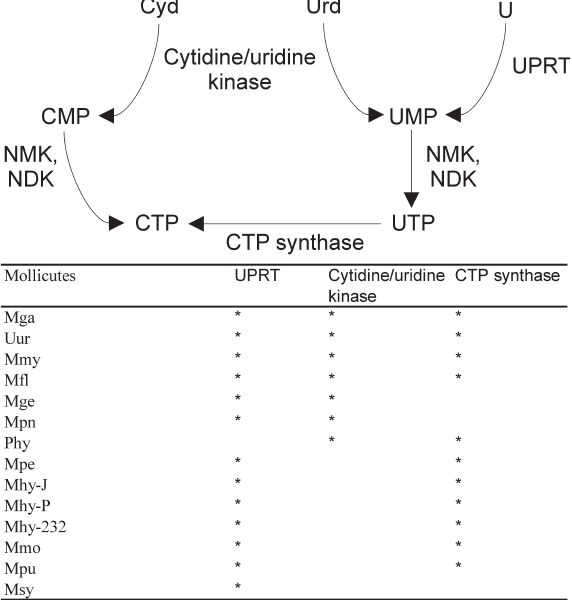
Figure 3 -Pathways for CTP and UTP synthesis in Mollicutes. Abbrevia- tions: Cyd, cytidine; Urd, uridine; U, uracil; CMP, cytidine monophos- phate; UMP, uridine monophosphate; CTP, cytidine monophosphate; UTP, uridine monophosphate; NMK, nucleoside monophosphate kinase; NDK, nucleoside diphosphate kinase; Mga, Mycoplasma gallisepticum ; Uur, Ureaplasma urealyticum ; Mmy, Mycoplasma mycoides ; Mfl, Mesoplasma florum ; Mge, Mycoplasma genitalium ; Mpn, Mycoplasma pneumoniae ; Phy, Onion Yellow Phytoplasma; Mpe, Mycoplasma penetrans ; Mhy, Mycoplasma hyopneumoniae (strains J, 7448 [P], and 232); Mmo, Mycoplasma mobile ; Mpu, Mycoplasma pulmonis ; Msy, Mycoplasma synoviae